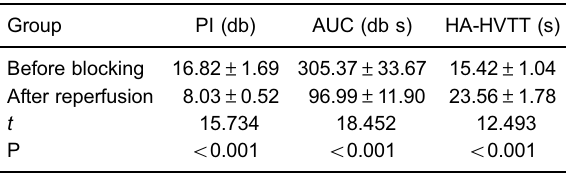
Table 3. Comparison of hepatic perfusion parameters before blocking and after reperfusion. Group PI (db) AUC (db